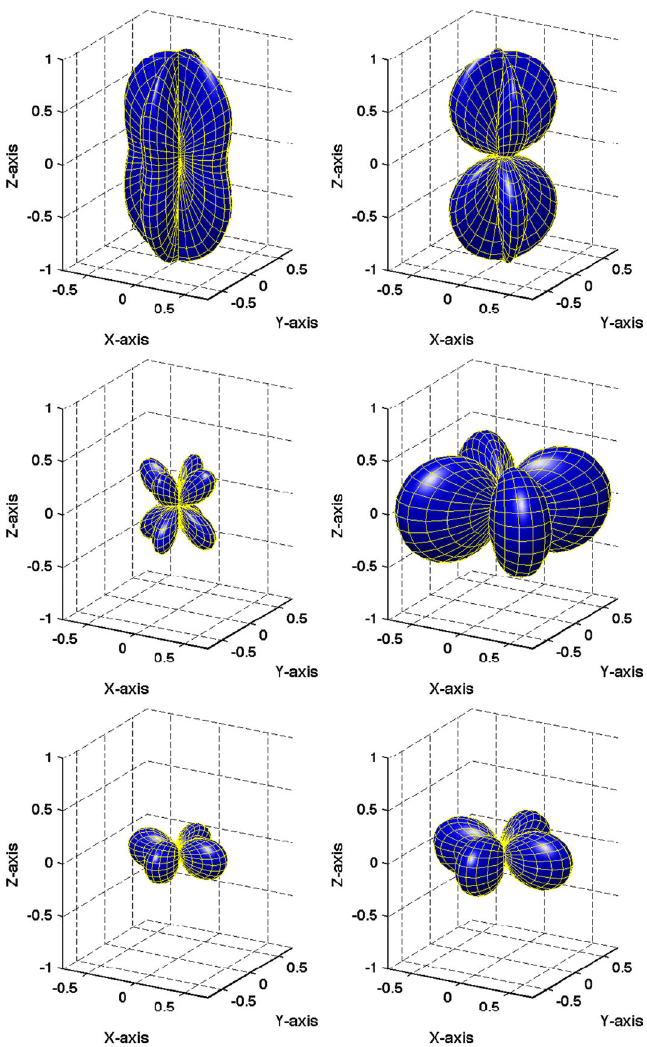
Fig. 64 Antenna patterns for Michelson interferometer strain response | R A ( ˆ n ) | evaluated in the small- antenna limit, f = 0. The top two plots correspond to the two tensor modes, A = + , × . The middle two plots correspond to the two vector modes, A = X , Y . The bottom two plots correspond to the two scalar modes, A = B , L . The interferometer arms point in the ˆ x and ˆ y directions